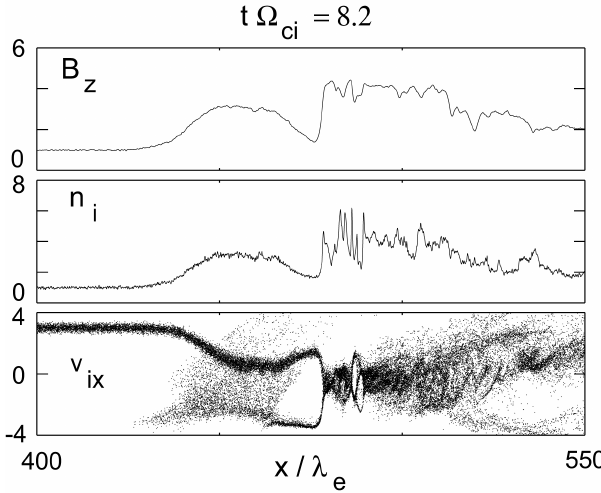
Fig. 4. From top to bottom: magnetic field B z component, ion den- sity n i , and ion v ix phase space versus shock normal direction x for the ion to electron mass ratio 400 run.